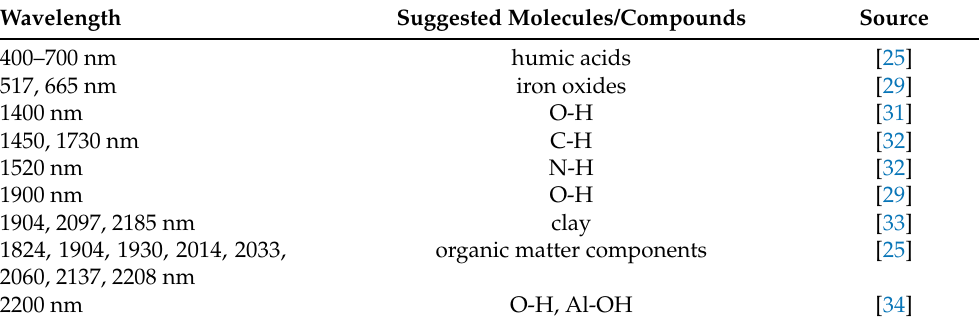
Table 1. Spectral